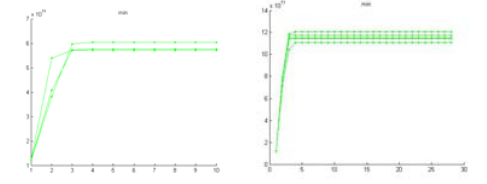
Figure 9: Converting the matrix of the best Solution to the